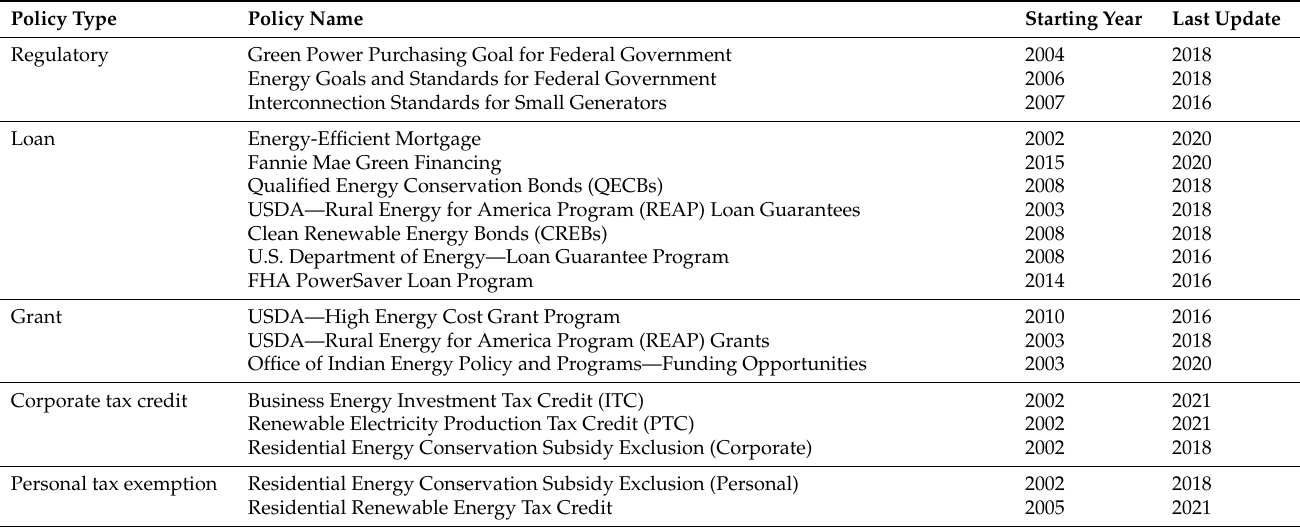
Table 5. Current Federal Incentives in the